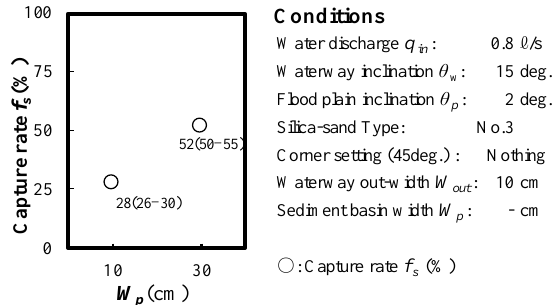
Figure 6. Effects of changing the basin width W p on the capture rate f s of the sediment retarding basin.